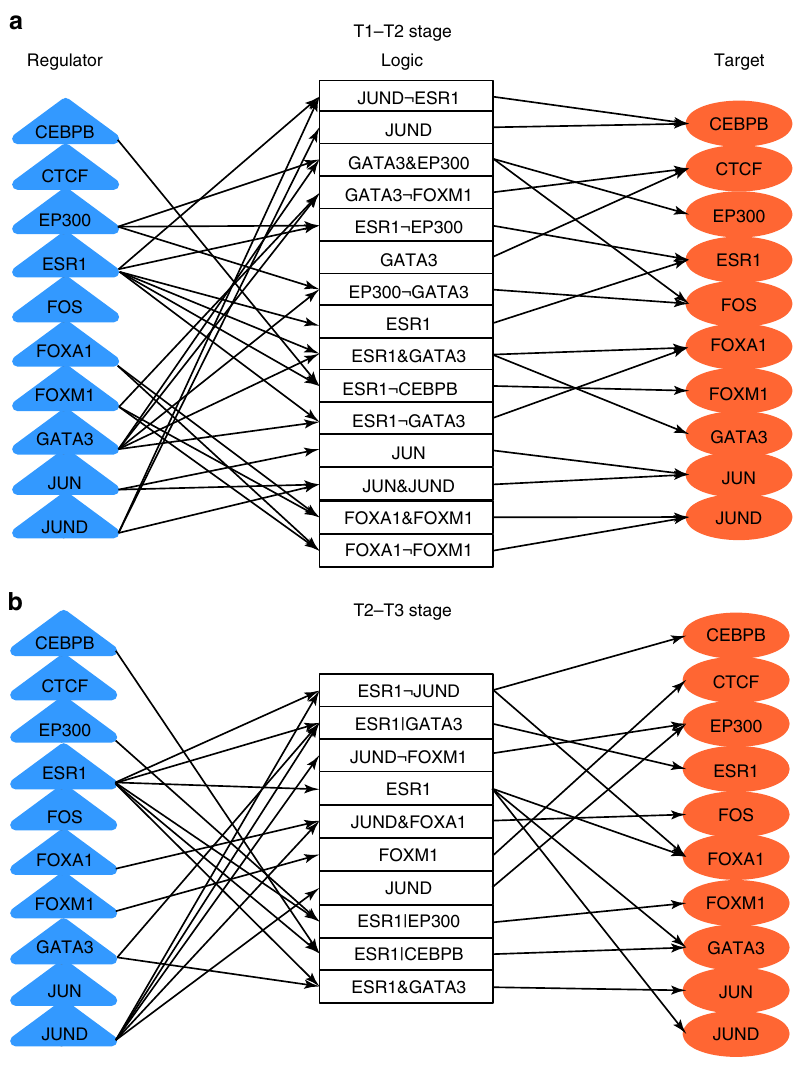
Fig. 4 Regulatory logics formed by ten TFs during the E2-treated breast cancer development. Time-course gene expression microarray data was employed. The data represents 12 time points 0, 1, 2, 4, 6, 8, 12, 16, 20, 24, 28, and 32 h (h) following the E2 treatment, which was divided into three stages, T1 (0 – 2 h), T2 (4 – 20 h), and T3 (24 – 32 h). a represents T1-T2 stages and b represents T2-T3 stages. Logic relationships include AND (&), NOT ( ¬ ), and OR ( | )